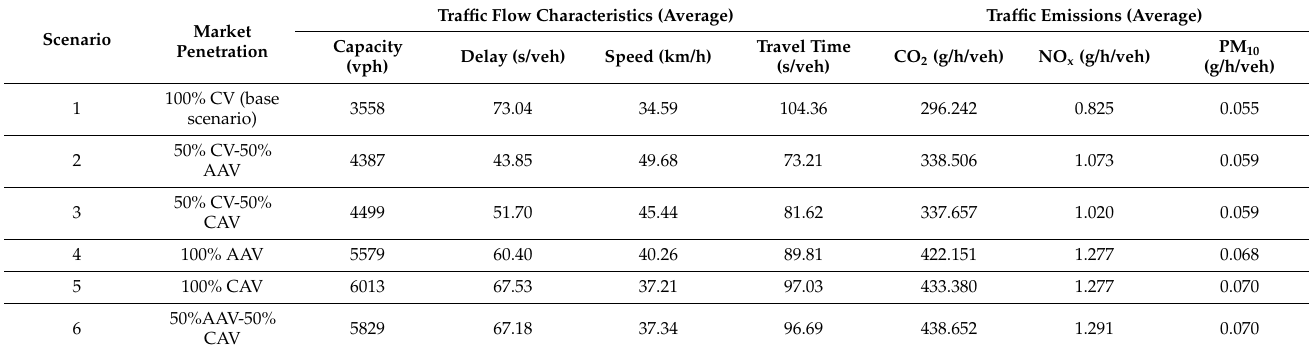
Table 5. Traffic flow characteristics and traffic emissions for the weaving segment.